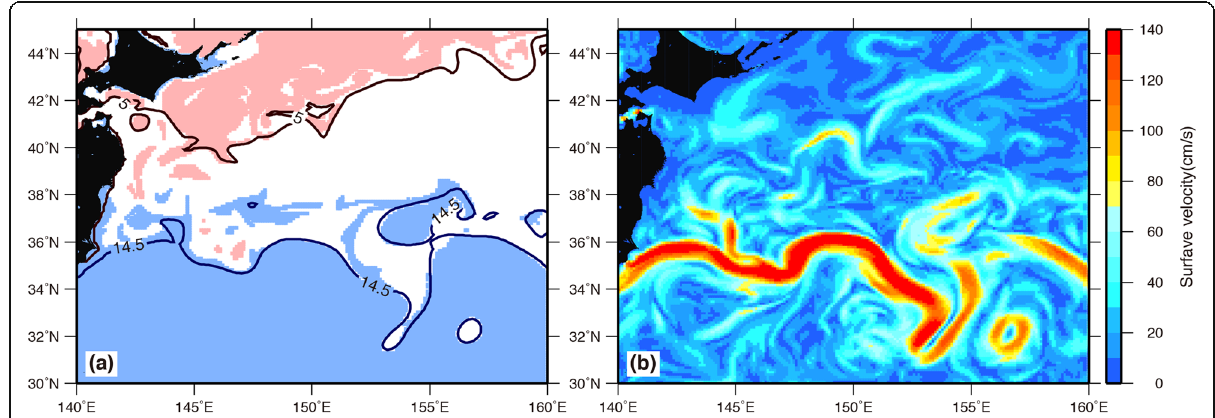
Fig. 3 Distribution of a the TS based Oyashio water (red shade) and TS based Kuroshio water (blue shade) and b surface absolute velocity in April 15, 2002. Isotherm of 5 °C represents the value at 100 m and is a traditional definition of the Oyashio front, and isotherm of 14.5 °C represents the value at 200 m and is a traditional definition of the Kuroshio front. Data are from FORA-WNP